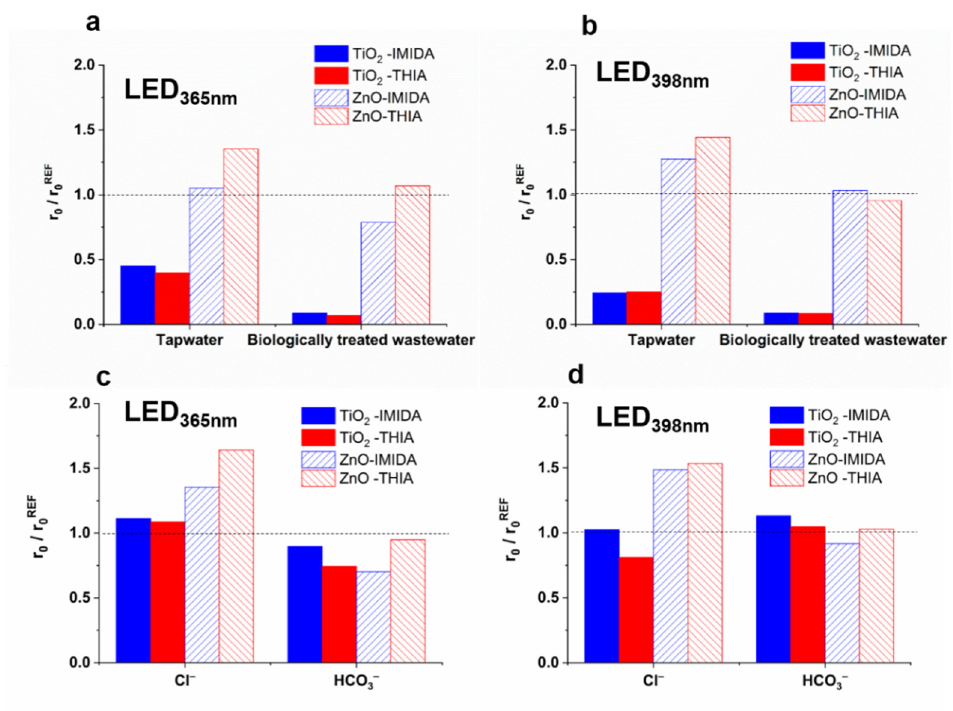
Figure 8. The relative initial transformation rates of IMIDA and THIA measured in different water a , b ), and in the presence of Cl − and HCO 3 − ( c , d matrices ( a , b ), and in the presence of Cl − and HCO 3 − ( c , d ). matrices (